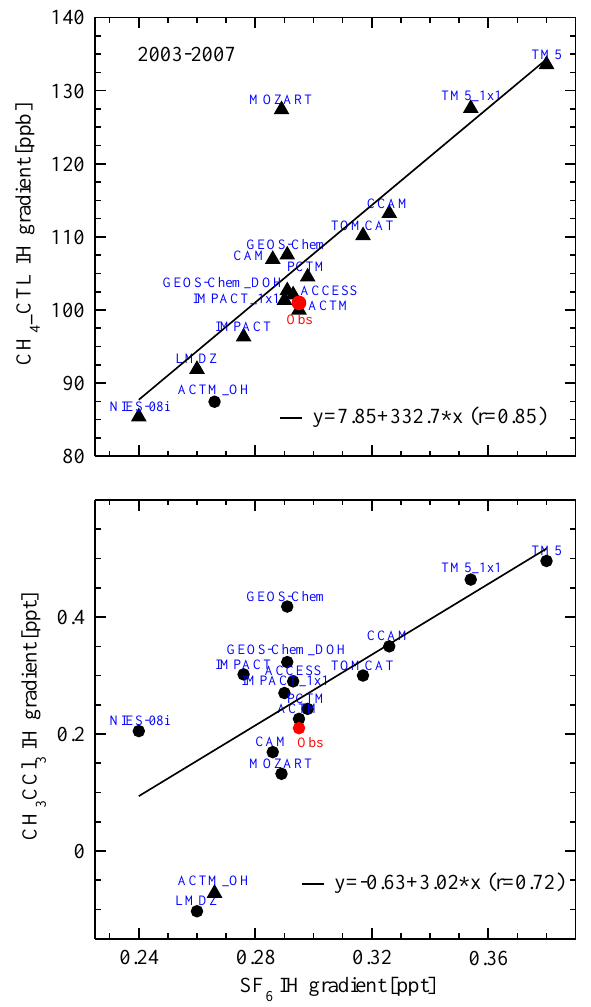
Fig. 10. Correlation between IH gradients of SF 6 with that of CH 4 and CH 3 CCl 3 are depicted, using average values for the period 2003–2007 and for 4 sites as in Fig. 7. ACTM OH is excluded from the linear fitting because the SF 6 emissions are not as per the